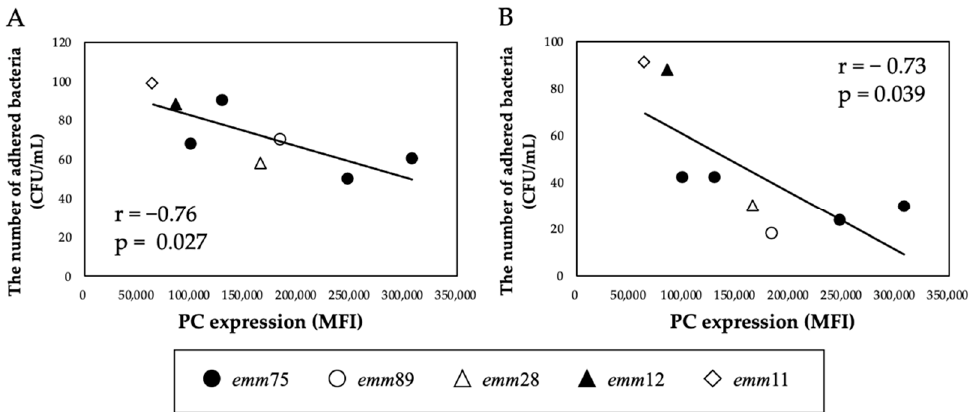
Figure 3. Inhibitory effect of TEPC-15 and ABT-491 on the adhesion of Streptococcus pyogenes. Inhibition of adhesion by pretreatment with TEPC-15 ( n = 5, r = − 0.76, p = 0.027) ( A ) and ABT-491( n = 5, r = − 0.73, p = 0.039) ( B ) showed a negative correlation with PC expression in Streptococcus pyogenes . MFI, mean fluorescence intensity; PC, phosphorylcholine.